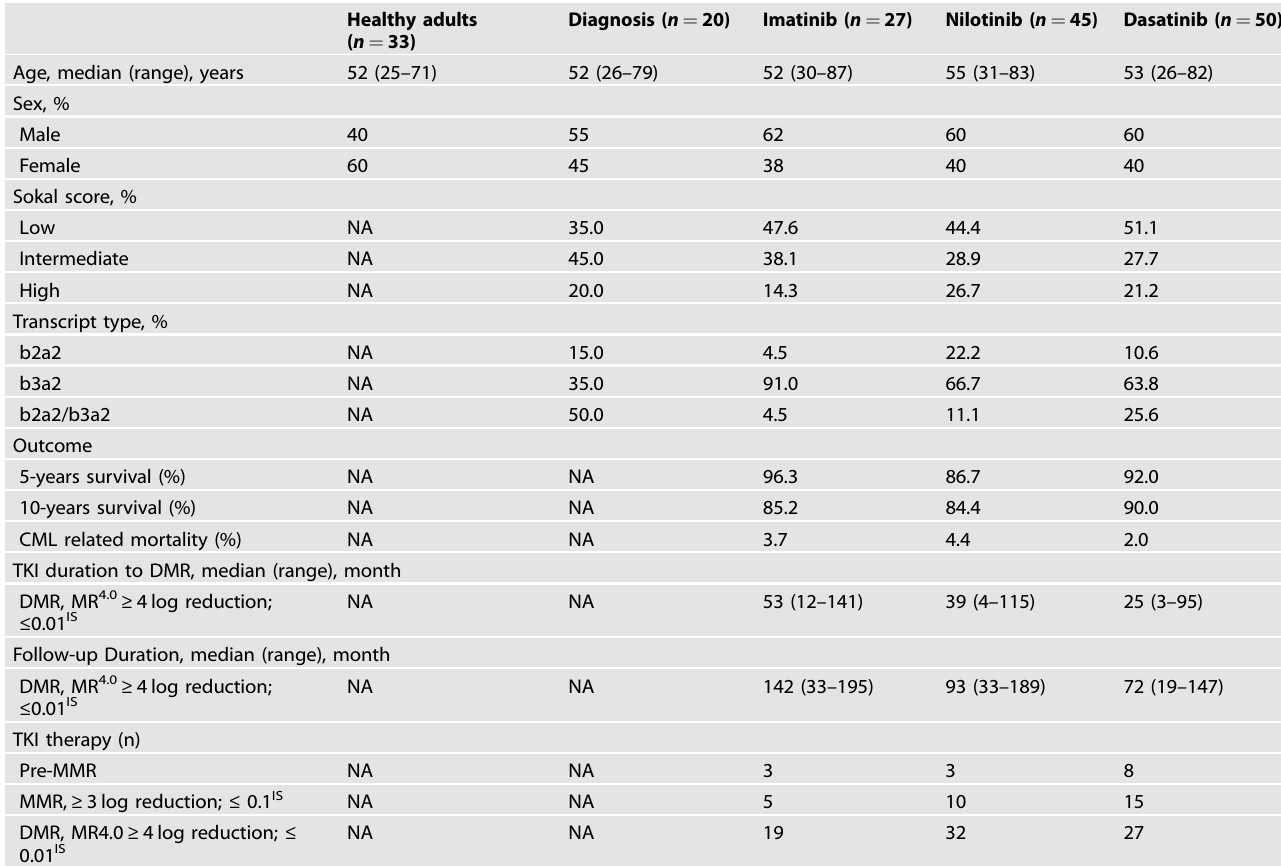
Table 1. Demographics of the recruited patients with CML in chronic